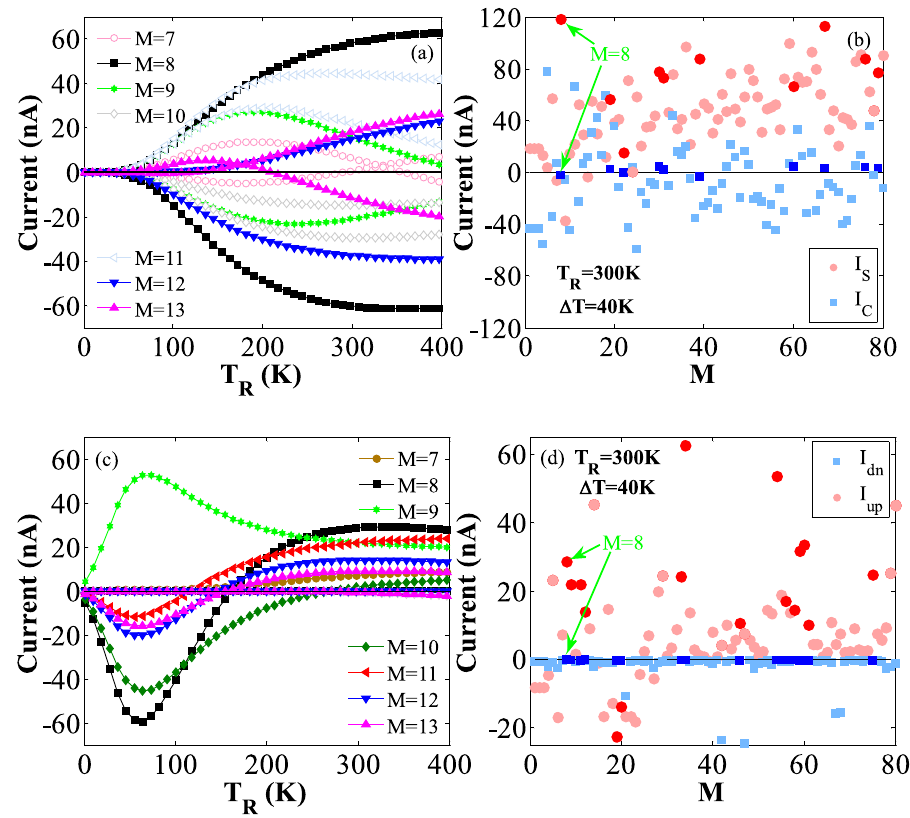
Figure 8. The variations of ( a ) I up and I dn versus T R at ∆ T = 40 K for the lengths of M = 7–13; Note that the plots shown in the positive and negative regions of the Y-axis are related to I up and I dn , respectively, ( b ) I S and I C versus M at T R = 300 K and ∆ T = 40 K, and the selected external fields, in the SSE case, ( c ) I up and I dn versus T R at ∆ T = 40 K for M = 7–13; Note that the plots on the X axis are related to I dn , and the others to the I up ( d ) I up and I dn versus M at T R = 300 K and ∆ T = 40 K, and the adopted external fields, in the SFE case.